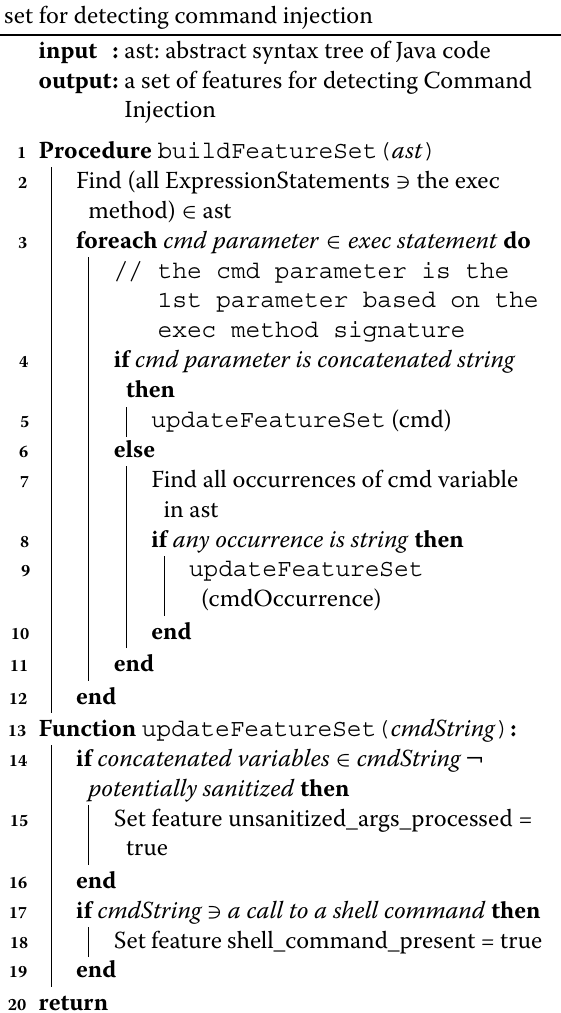
Algorithm 3: Procedure for building the feature set for detecting command